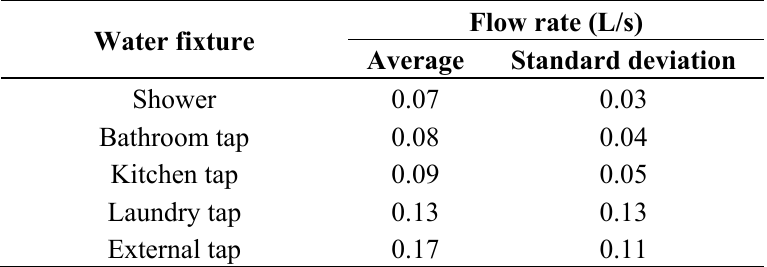
Table 2. Flow rate of water fixtures in low-income households.